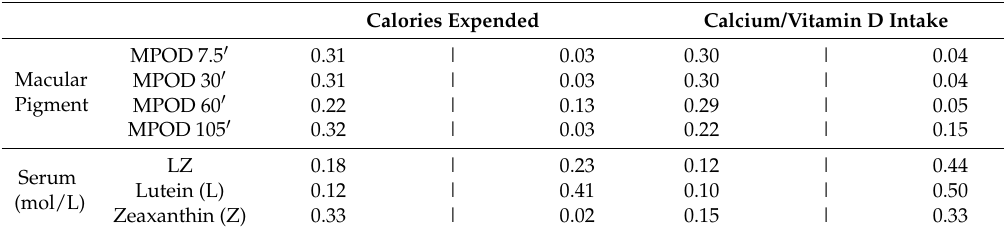
Table 3. Pearson-product moment correlation coefficients and significance values ( r | p ) for associations between health habits (calories expended and calcium/vitamin D intake) and LZ status (retinal and serum). Calories Expended Calcium/Vitamin D